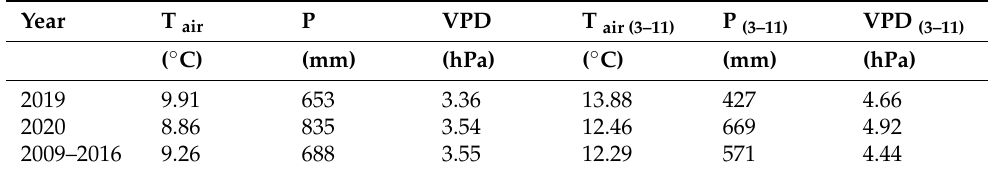
Table 1. Average values of air temperature (T air ) and vapour pressure deficit (VPD), and sum values